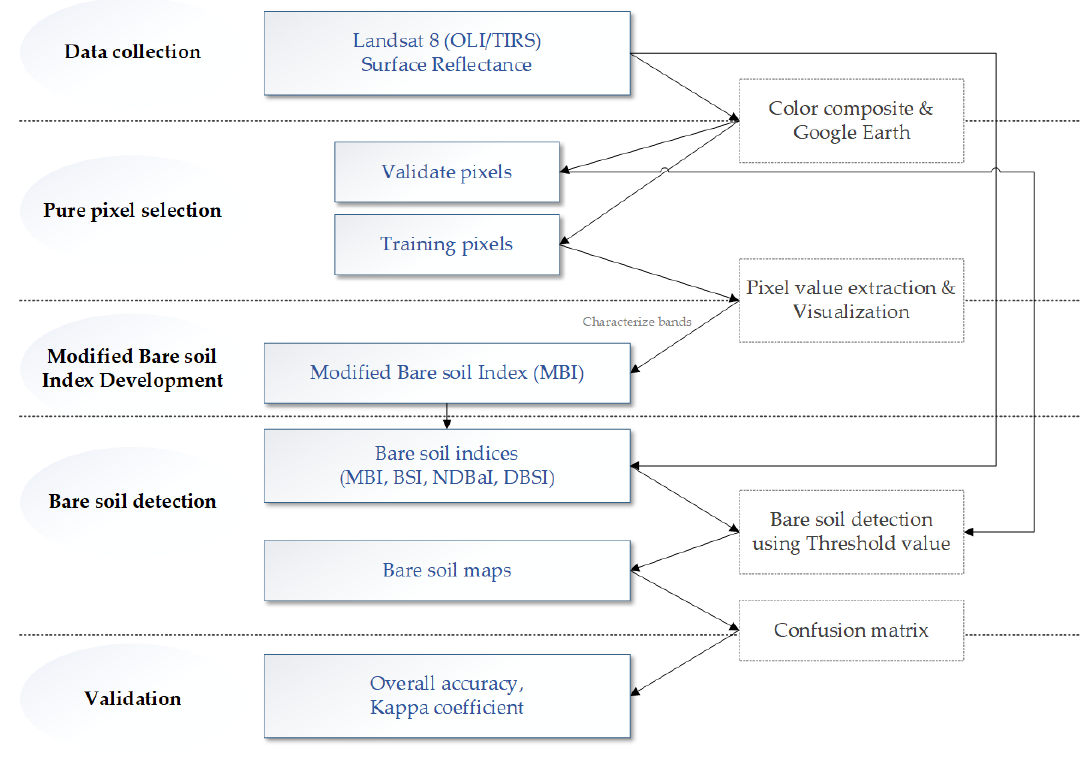
Figure 1. Flowchart showing the detailed research methodology to develop and validate the modified bare soil index.